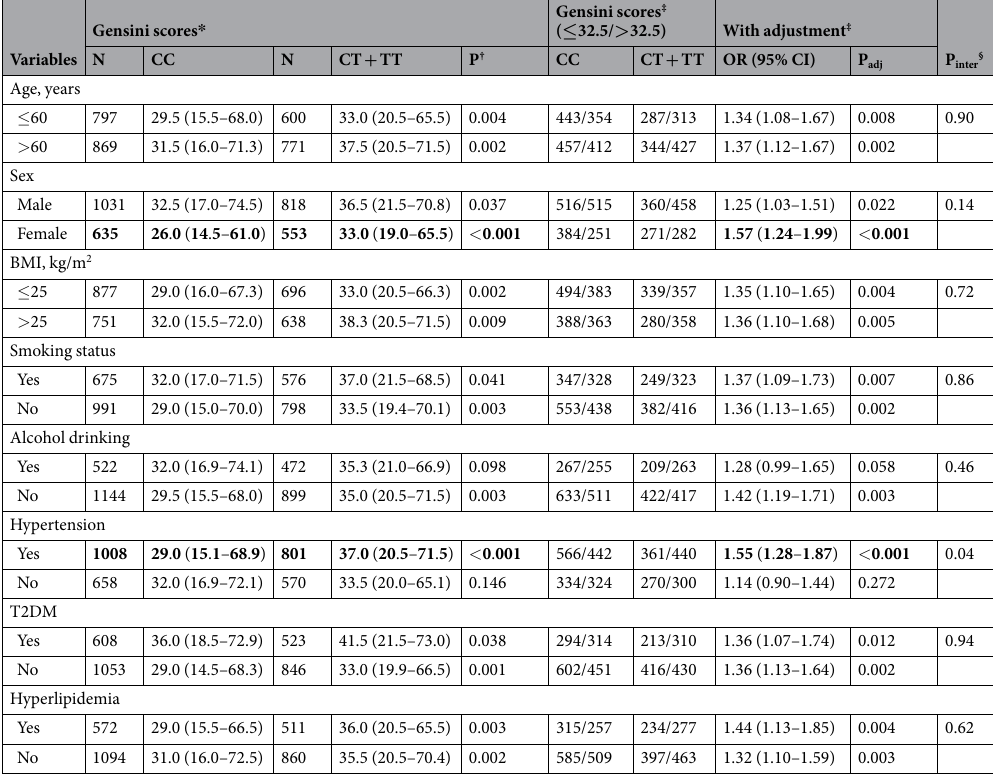
Table 4. Association of SNP rs11615 with the severity of coronary atherosclerosis. N, number; OR (95CI), odds ratio (95% confidence interval); BMI, body mass index; T2DM, type 2 diabetes mellitus. * Gensini scores are expressed as median (interquartile range) because of the skewed distributions. † P values were obtained from the Mann-Whitney U test. ‡ CAD patients were classified into two groups based on the median (32.5) of Gensini scores, and then adjusted OR (95% CI) and P adj values were obtained from logistic regression analyses after adjusting for age, sex, BMI, smoking status, alcohol drinking and histories of T2DM, hyperlipidemia and hypertension. § P inter values were obtained from the multiplicative likelihood ratio test to assess the interactions between SNP rs11615 and selected variables in CAD risk. Bold values indicate statistically significant after the Bonferroni correction (P < 0.05/48 ≈ 1.04 × 10 − 3